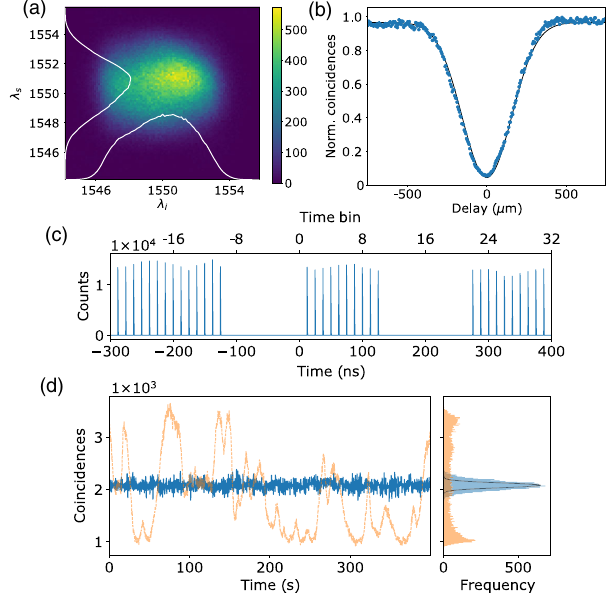
FIG. 9. (a) Joint spectral intensity of the source, with the number of counts indicated by color. (b) Hong-Ou-Mandel interference with a visibility of 95.3(2)%. The error bars, due to Poissonian counting statistics, are barely visible. (c) Timing histogram of counts at the unused output port of the FBS, demonstrating pulse picking. (d) Twofold coincidences after the interferometer for a freely running (orange) and locked (blue) loop phase. The black line in the histogram indicates fluctuations due to Poissonian